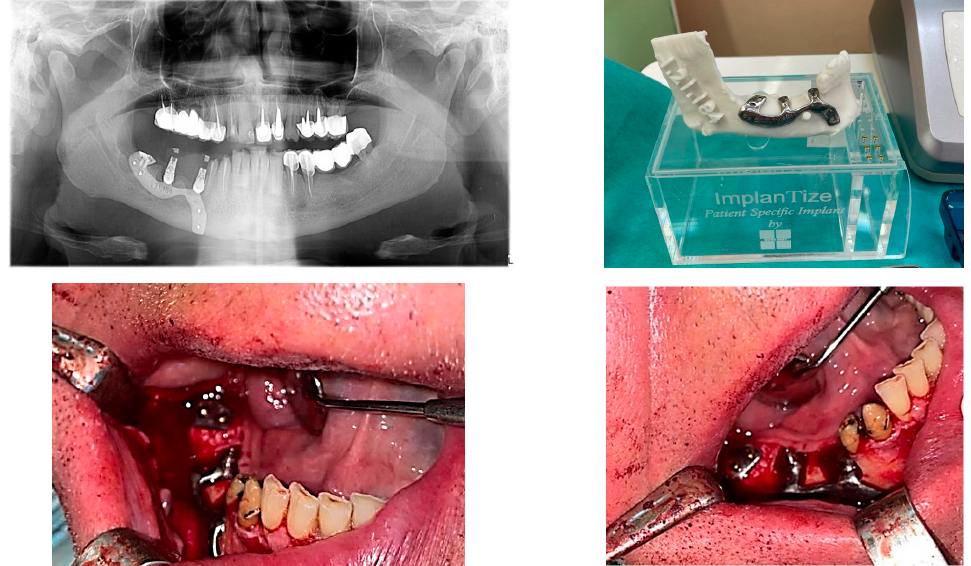
Figure 5. A patient with a terminal edentation on the right side of the mandible (missing teeth 4.5, 4.6, 4.7, 4.8) treated with a partially subperiosteal implant.